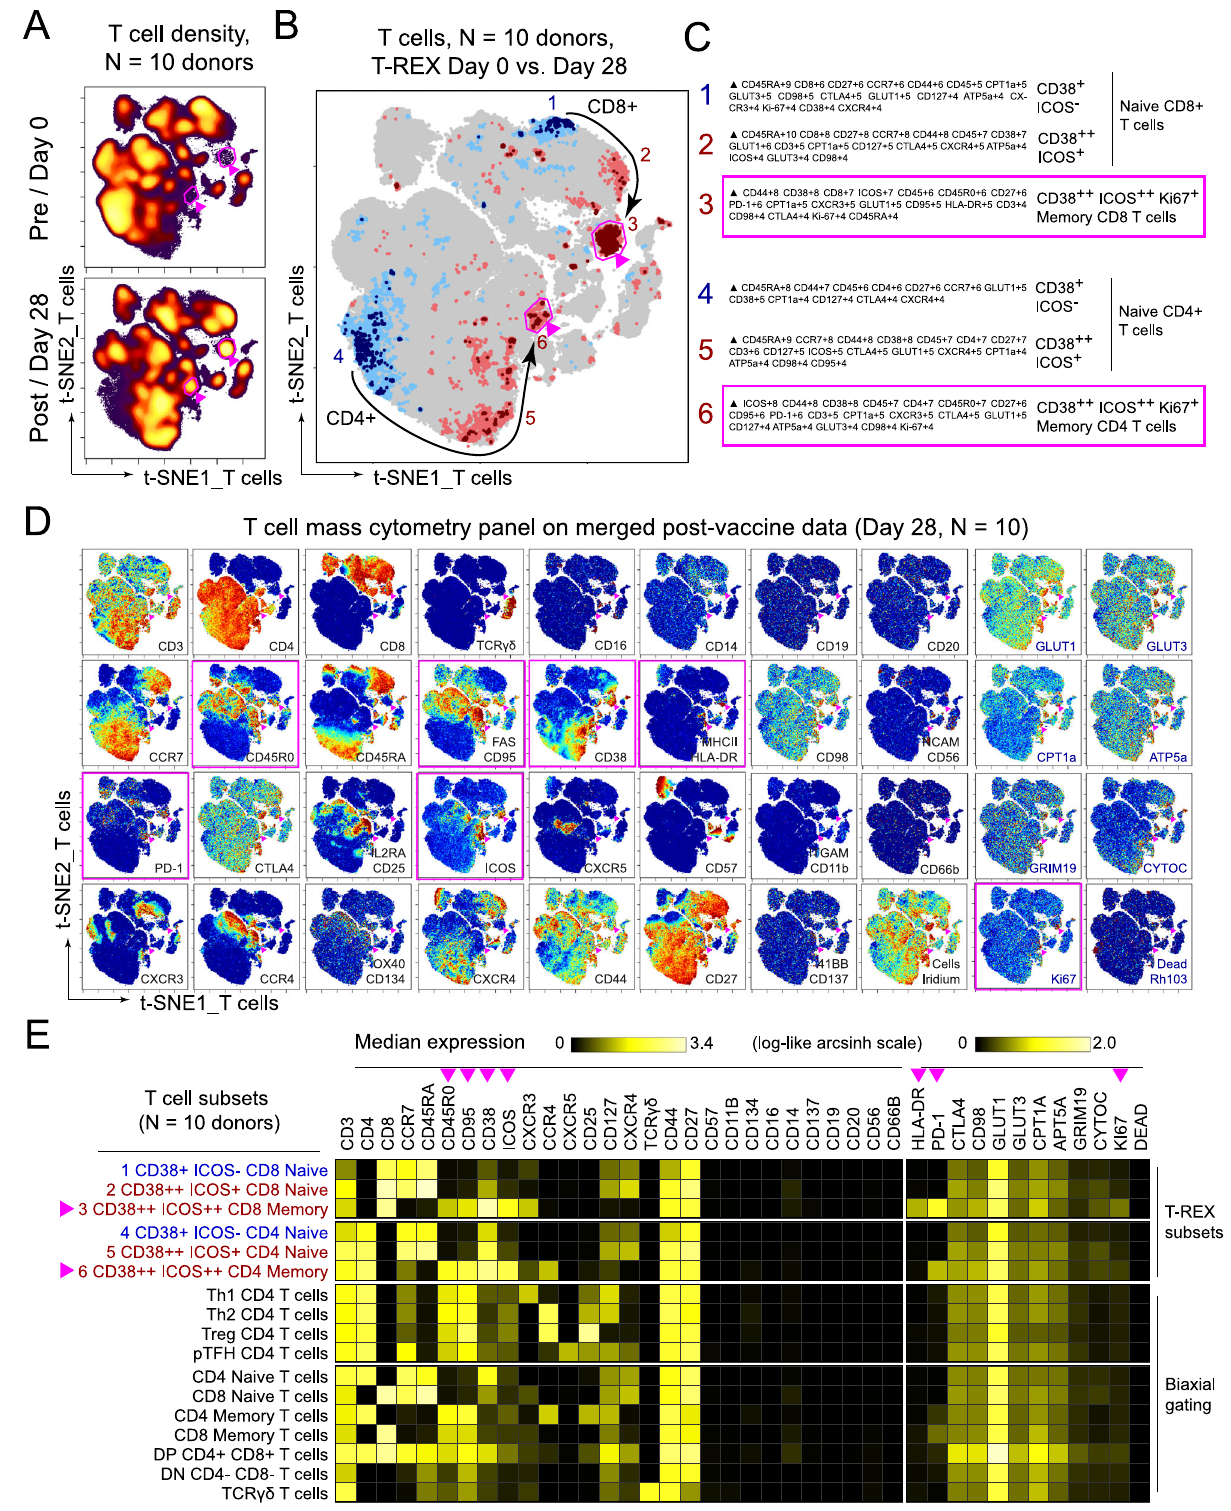
(Supplementary Fig. 2F). Especially notable were the late collection time points in which three participant samples produced more IL-6 when incubated with S1 protein than samples stimulated with activation beads. Samples from day 105 also showed an increase in the frequency of IFN- γ -producing CD8 + T cells when restimulated with S1 protein after 11 days of culture